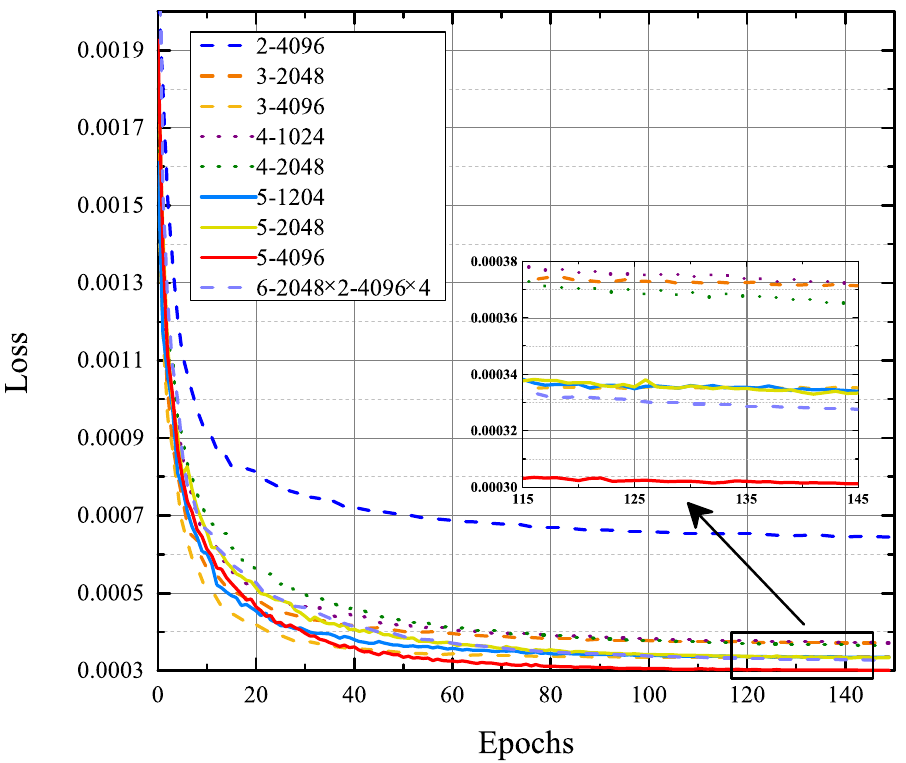
Figure 7. Evolution of loss on the validation set in the training of different FC